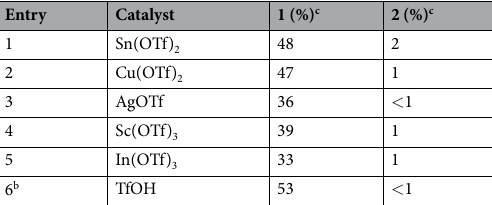
Table 2. Conversion of an authentic starch sample into methyl levulinate ( 1 ) and methyl lactate ( 2 ) using metal triflate catalysts a . a Reaction conditions: starch (50 mg), methanol (5.0 mL), catalyst (0.024 mmol), naphthalene (0.156 mmol), Ar (5 atm), 24 h, 160 °C. All reactions were performed twice, and the yields of 1 and 2 are average values. b Catalyst (0.048 mmol). c Yields (%) of each product are carbon-based. The amounts of 1 and 2 produced were determined by 1 H NMR analysis.